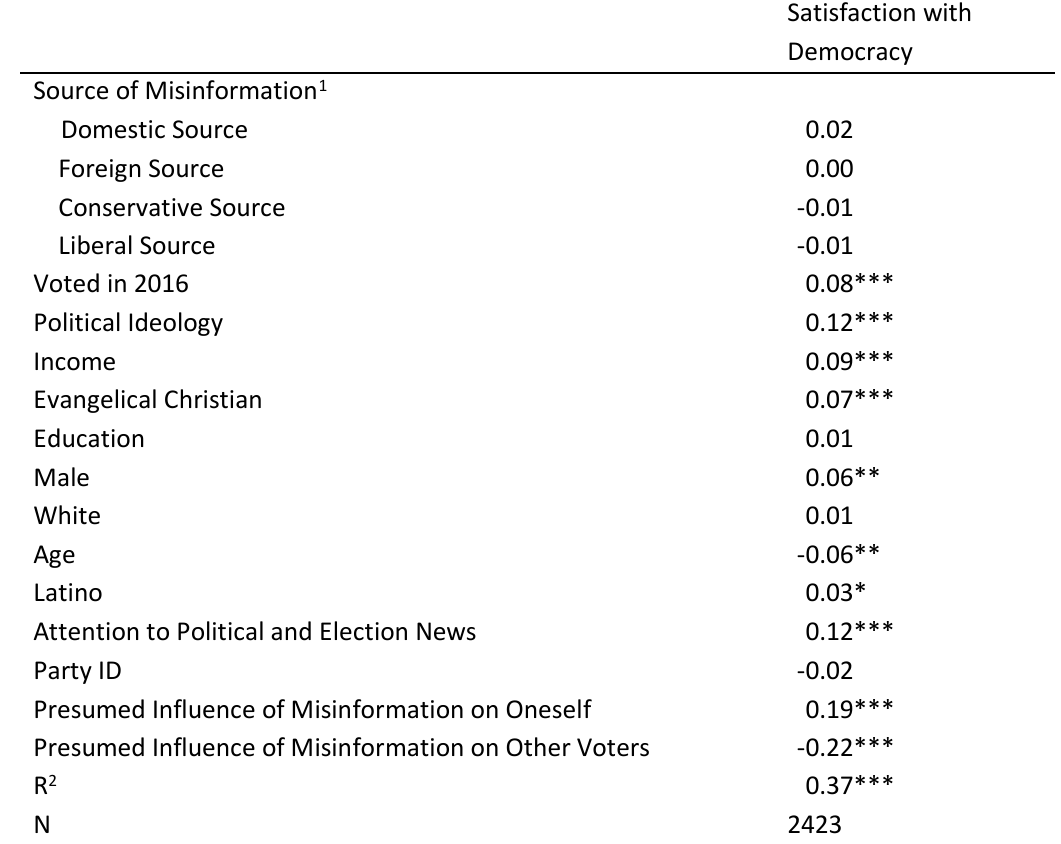
Table B2 . OLS regression for Figure